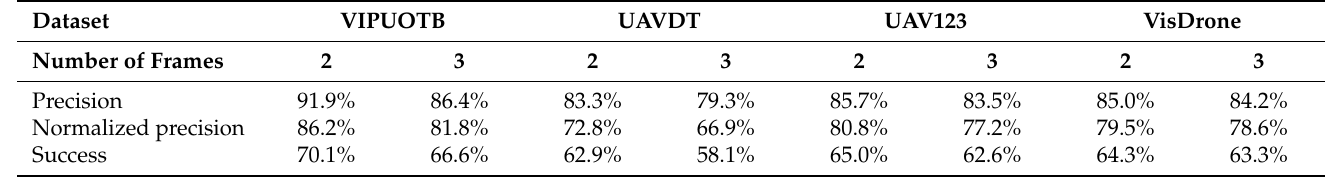
Table 6. The comparison tracking results of utilizing different numbers of